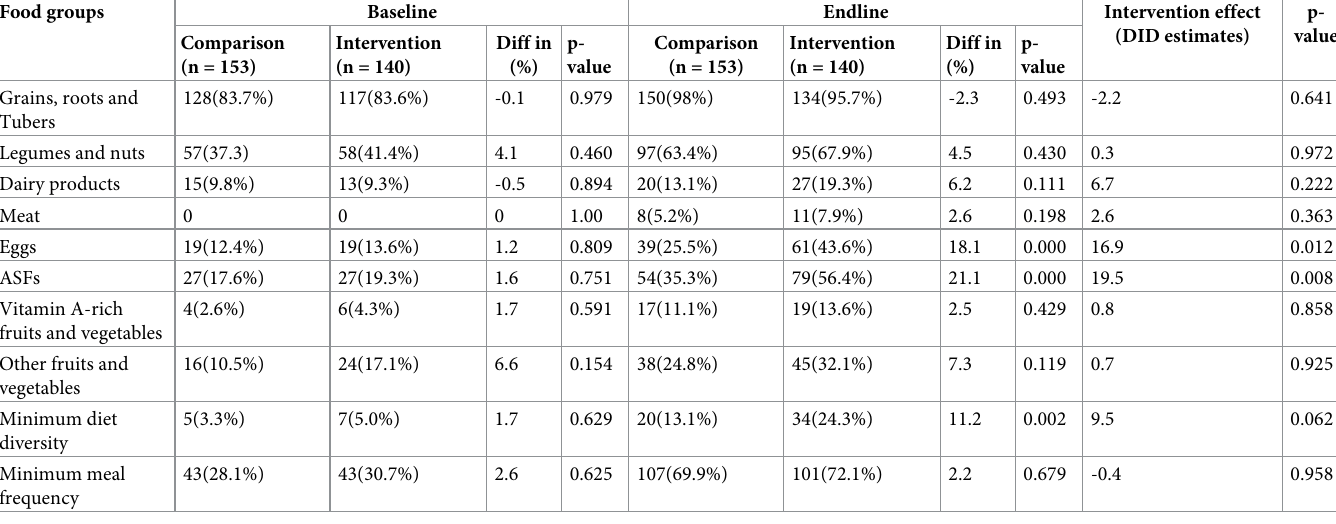
Table 4. Comparison of feeding practices between the intervention and comparison groups of children in rural districts of Tigray region, Ethiopia (difference-in- difference analysis). Food groups